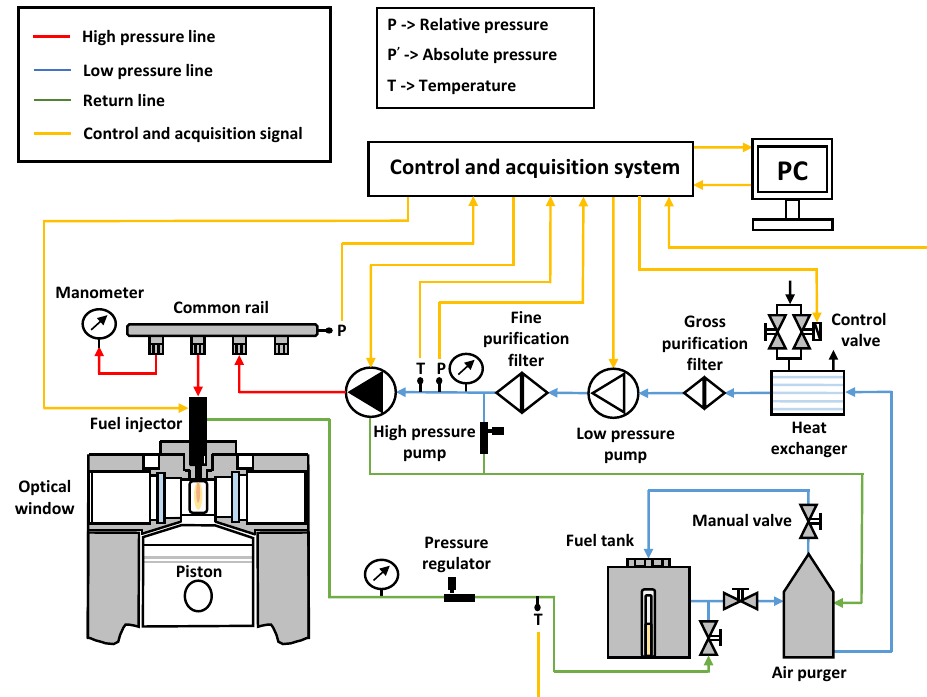
Figure 4. Scheme of the independent fuel injection system.